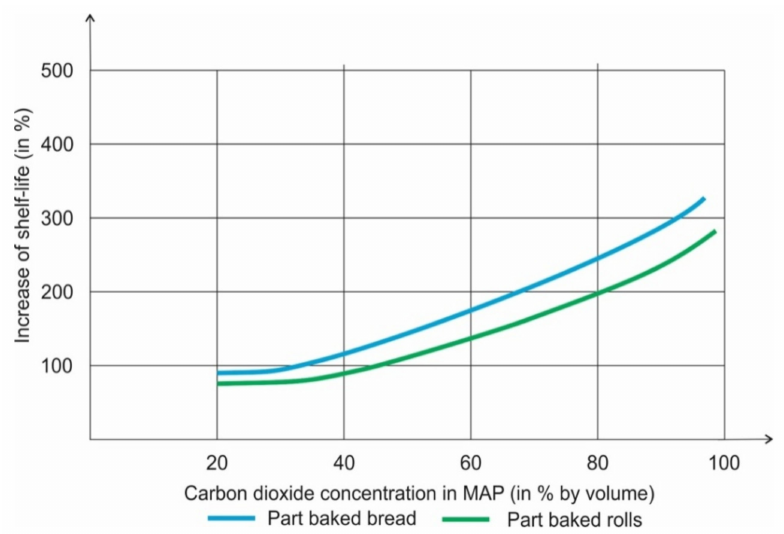
Figure 5. Increase in the shelf-life of a few types of bakery products with different levels of CO 2 ratios in MAP, reprinted with permission from WITT